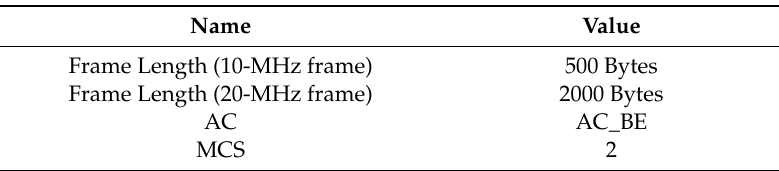
Table 1. Simulation